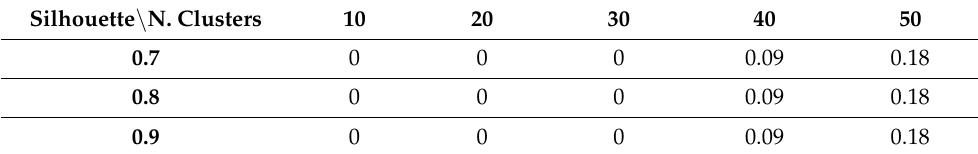
Table 58. Clustering performance in terms of silhouettes using normalized data. Silhouette \ N. Clusters